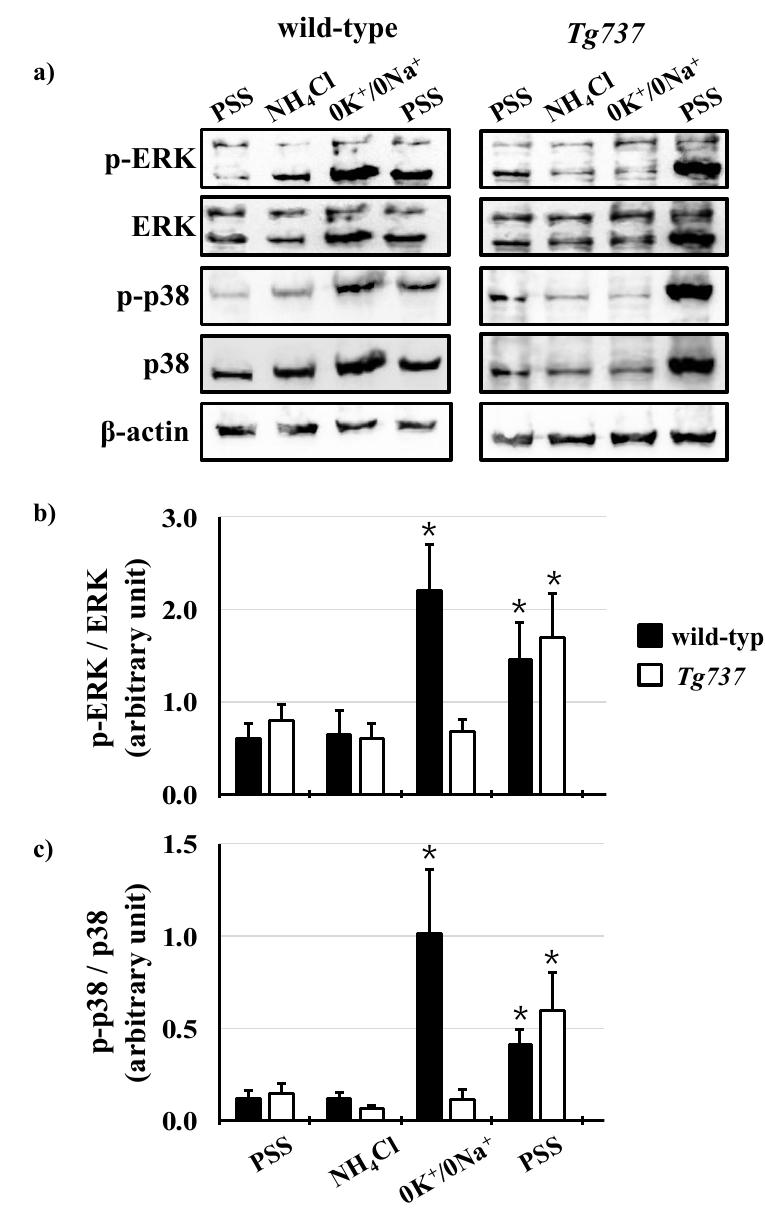
Figure 6. ERK1 / 2 and p38 phosphorylation during the NH 4 Cl pre-pulse in wild-type and Tg737 cells. ( a ) Representative immunoblots show ERK1 / 2 and p38 phosphorylation in wild-type and Tg737 cells as they are exposed to di ff erent solutions during the NH 4 Cl pre-pulse. ( b , c ) Bar graphs show mean p-ERK / ERK and p-p38 / p38. * indicates p < 0.05 as compared to control conditions; for ERK1 / 2 N = 6 for wild-type cells and N = 5 for Tg737 cells; for p38 N = 5 for wild-type cells and N = 5 for Tg737 cells.